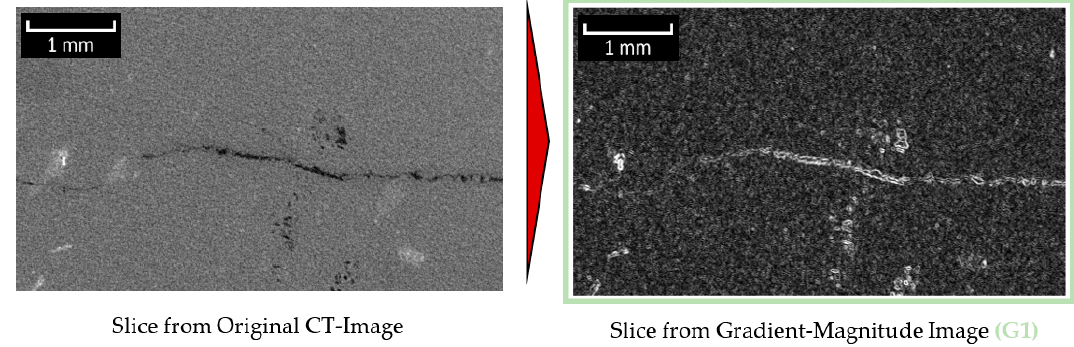
Figure 6. Generation of the gradient-magnitude image (based on figure in [10]).